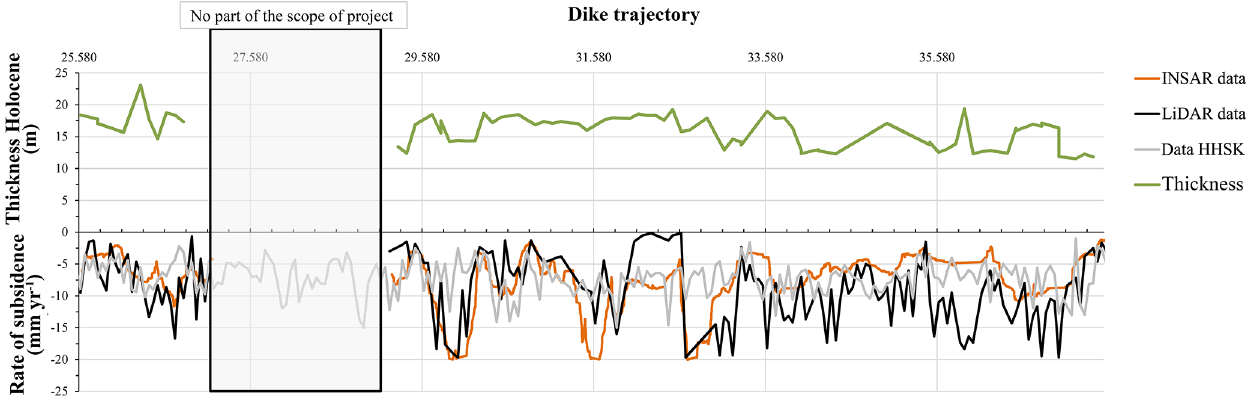
Figure 7. Comparison of determined subsidence rate with thickness Holocene soil